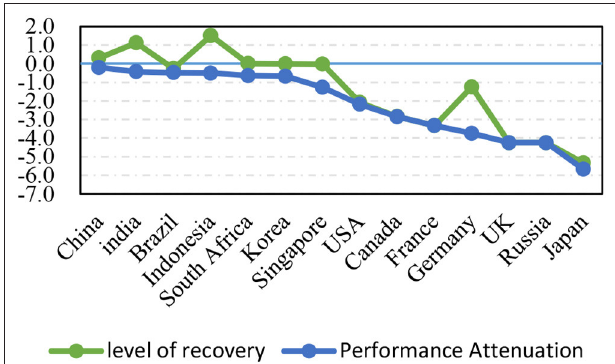
FIGURE 4 | Performance attenuation and recovery level.